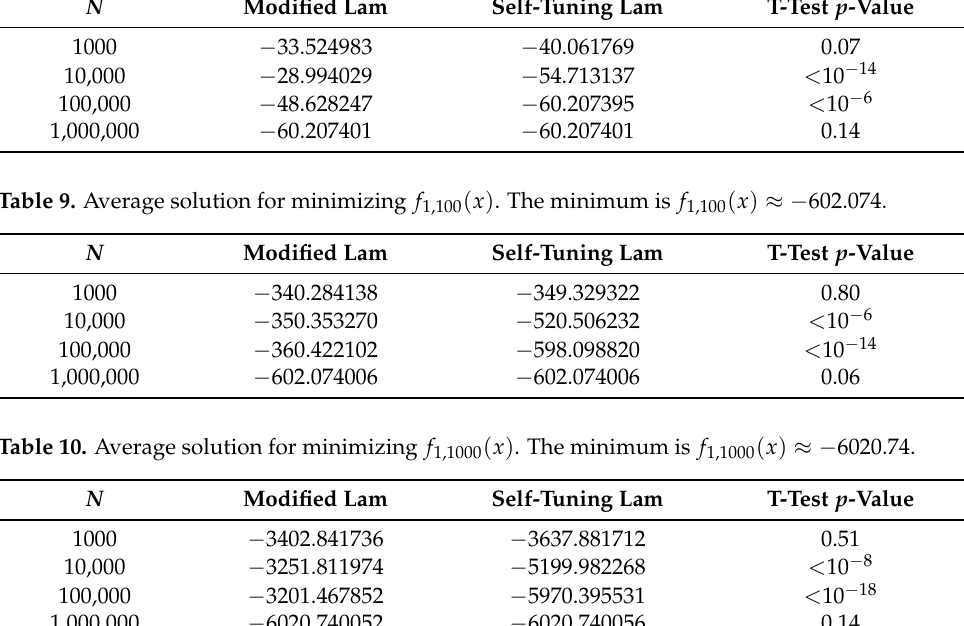
Table 8. Average solution for minimizing f 1,10 ( x ) . The minimum is f 1,10 ( x ) ≈ − 60.2074. N